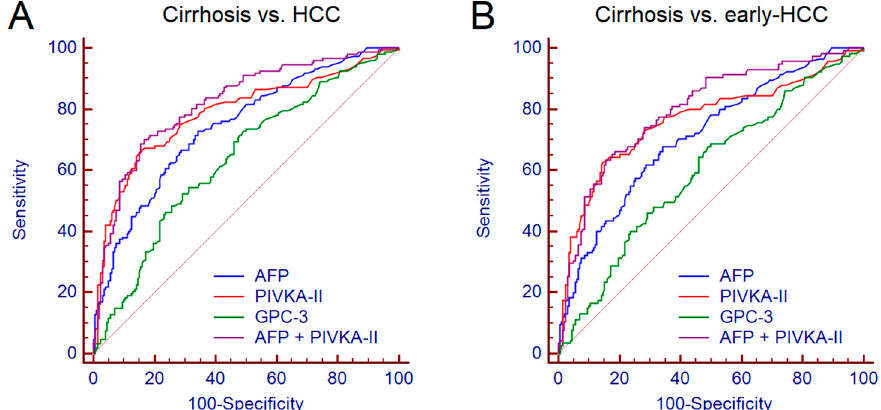
Figure 6. Comparison between the performance of AFP, PIVKA-II, GPC-3 and AFP + PIVKA-II for the discrimination between patients with cirrhosis and those with HCC ( A ) and between patients with cirrhosis and patients with early HCC ( B ). AUC was assessed by receiver operating characteristic curve analysis. Abbreviations—alpha-fetoprotein (AFP), area under the curve (AUC), glypican-3 (GPC-3), hepatocellular carcinoma (HCC), protein induced by vitamin K absence or antagonist II (PIVKA-II). Table 3. Diagnostic accuracy of AFP, PIVKA-II, GPC-3 alone or in combination for the discrimination between patients with cirrhosis and those with HCC.